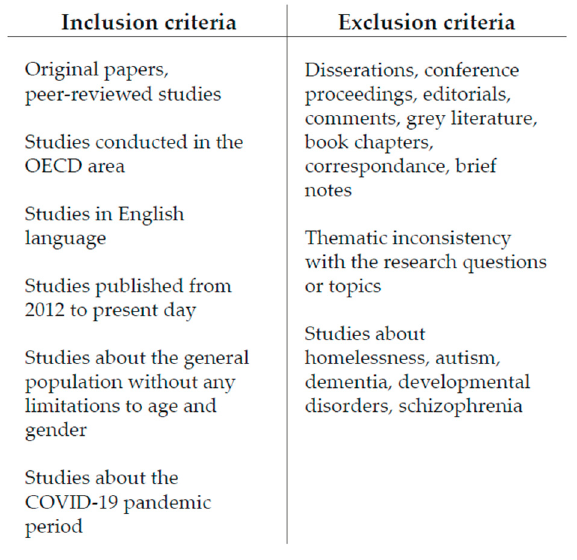
Figure 3. Eligibility criteria.